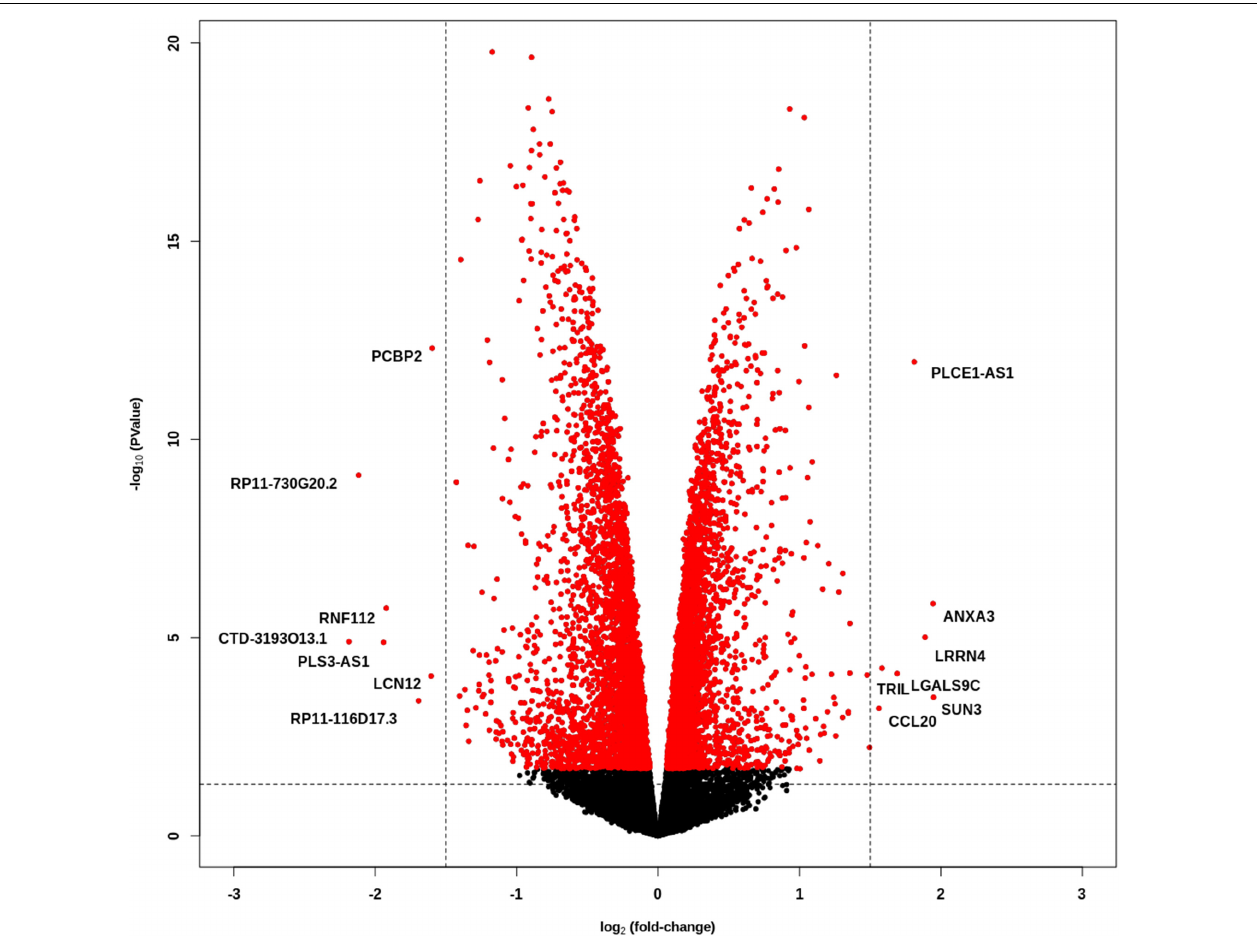
FIGURE 3 | PCBP2 knockdown does not lead to pronounced differential gene expression. Volcano plot of statistical significance against log 2 − fold change between PCBP2 knockdown and non-targeted control samples. The vertical dashed lines indicate a log 2 -fold change < –1.5 and > 1.5, respectively. Red dots denote genes with significant differential expression ( p < 0.05).